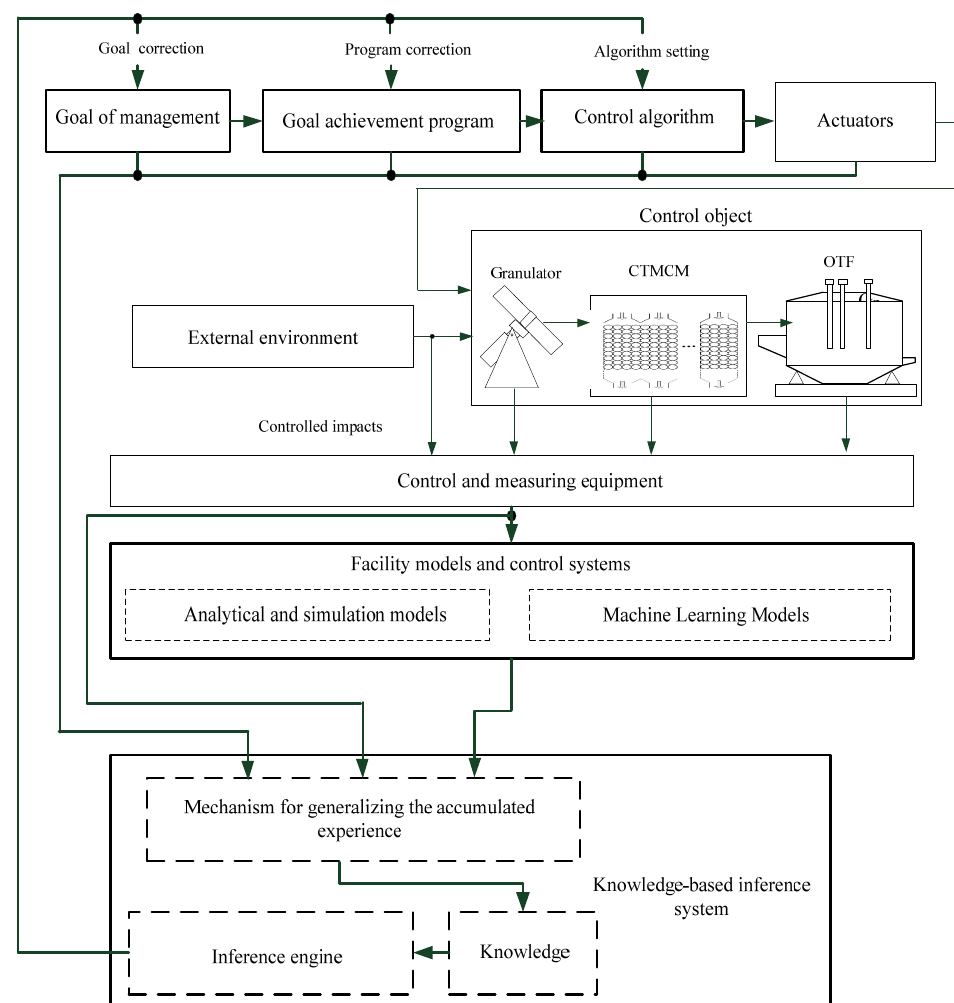
Figure 1. The structure of the CETS intelligent control system.